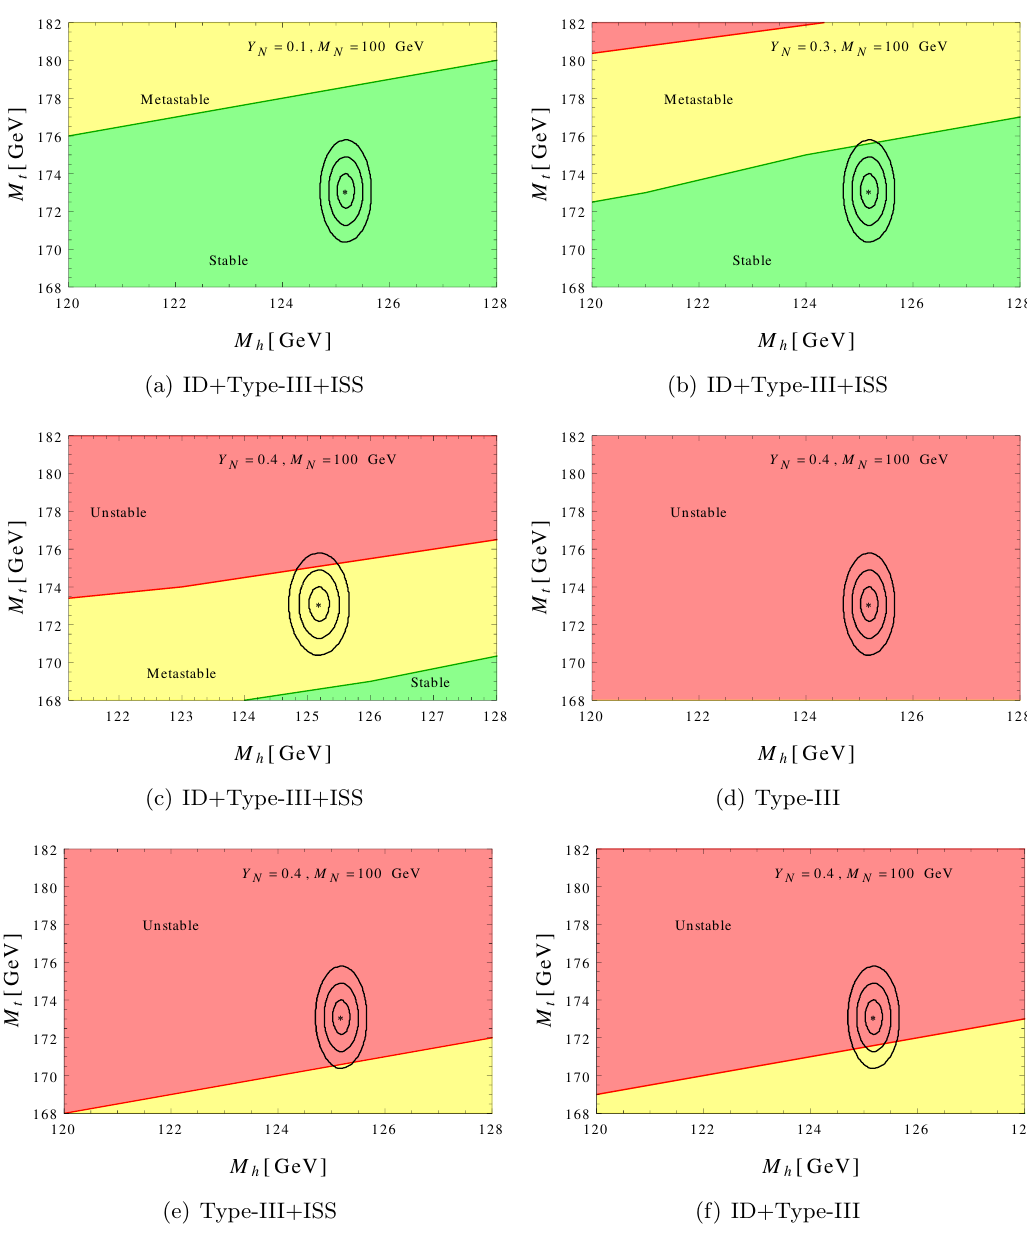
Figure 8 . Phase diagram in terms of Higgs and top pole masses in GeV with M N = 100 GeV in (cid:12)g- ure 8(a), 8(b), 8(c) for ID+Type-III+ISS scenarios with Y N = 0 : 1 ; 0 : 3 ; 0 : 4 respectively. Figure 8(d) is for Type-III only and (cid:12)gures 8(e), 8(f) are for Type-III+ISS with Y N = 0 : 4. The unstable, metastable and stable regions are depicted by the colours red, yellow and green respectively. The contours describe the current experimental 1 (cid:27); 2 (cid:27); 3 (cid:27) values with the dot specifying the central value in the ( M h ; M t )